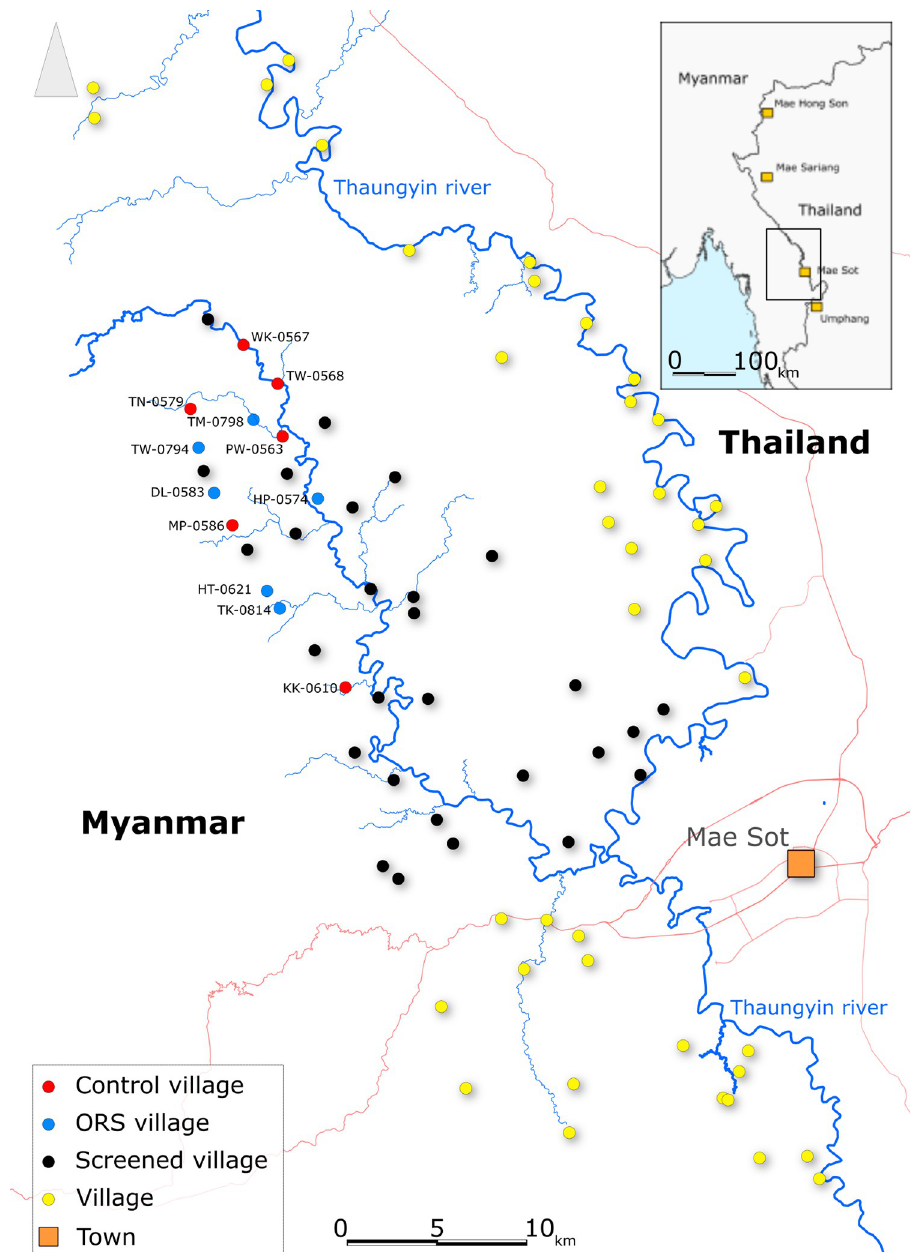
Fig 1. Map of the study area. Contains information from OpenStreetMap and OpenStreetMap Foundation, which is made available under the Open Database License.